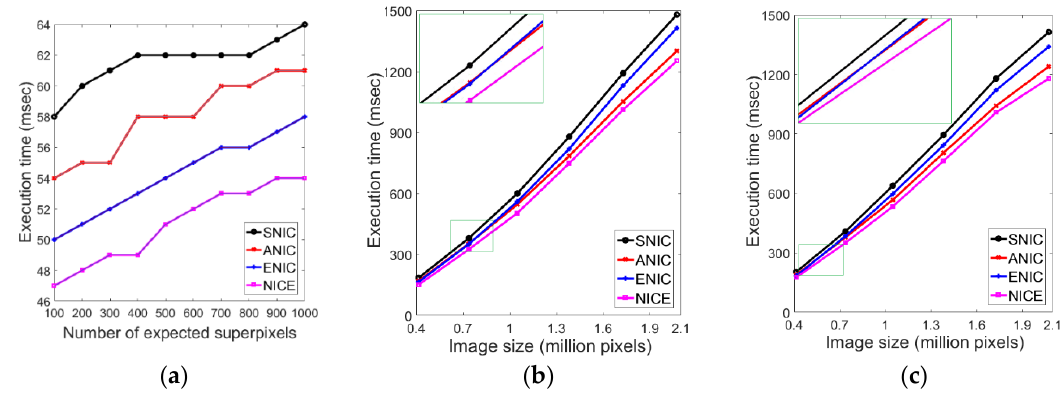
Table 3. Comparison of SNIC and the proposed three algorithms in terms of achievable segmentation accuracy (ASA).